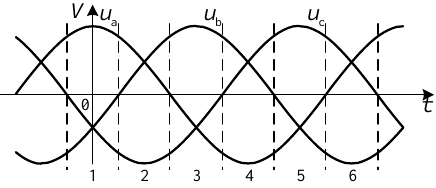
Figure 3. Input voltage sector division.